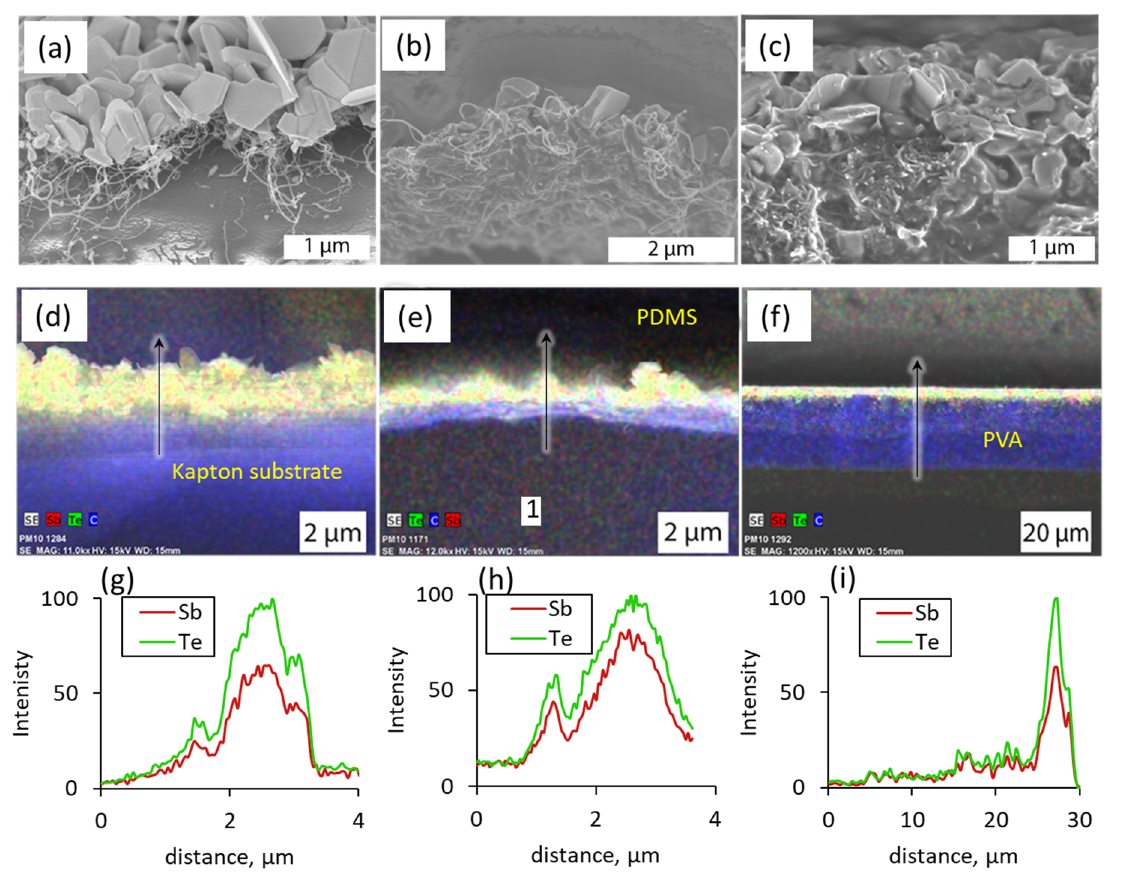
Figure 2. SEM images ( a – c ), EDS mapping ( d – f ) and EDS elemental line-scan profile ( g – i ) of the cross section of flexible films containing Sb 2 Te 3 -MWCNT heterostructures: ( a , d , g ) free standing on polyimide surface; ( b , e , h ) encapsulated in PDMS; and ( c , f , i ) mixed in PVA. Arrows in ( d – f ) represent the scanning direction.